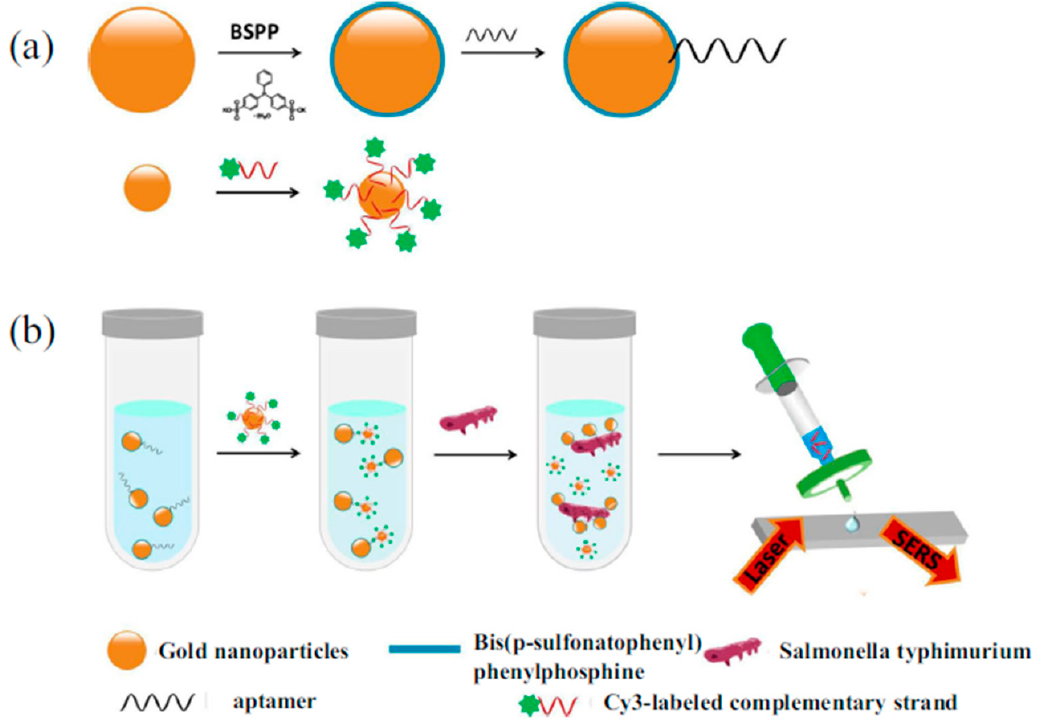
Figure 7. Schematic diagram of Au NPs based SERS aptasensors for the detection of Salmonella typhimurium . ( a ) Schematic diagram of the fabrication process of SERS aptasensors; ( b ) Schematic diagram of the detection process of Salmonella typhimurium . (Reprinted with permission from Springer, 2018 [68]).